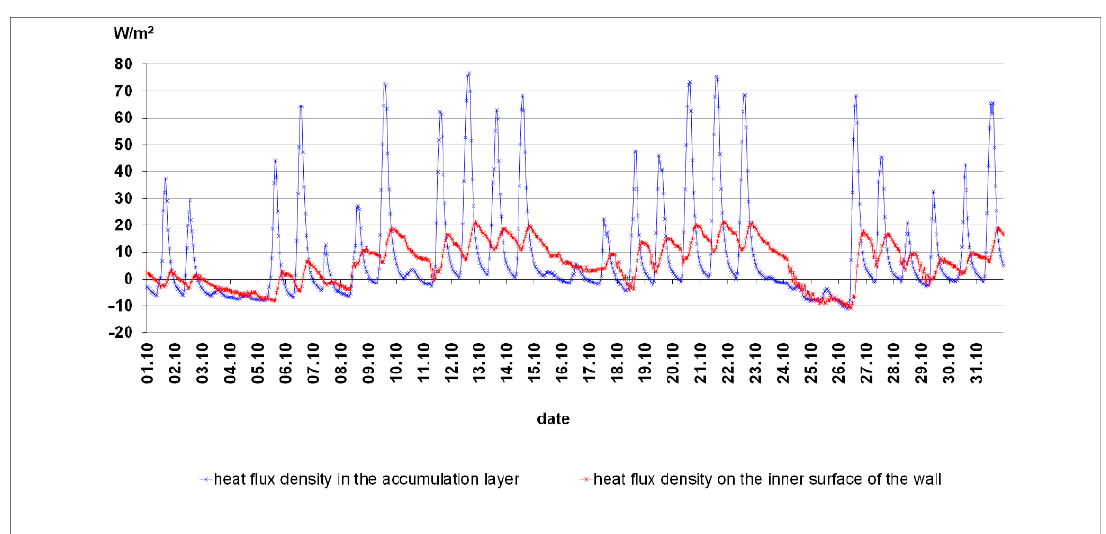
Figure 15. Graph of the global solar irradiance incident on the southern vertical plane in October. The energy gains from solar radiation collected during sunny days were used during cloudy days (Figure 16).